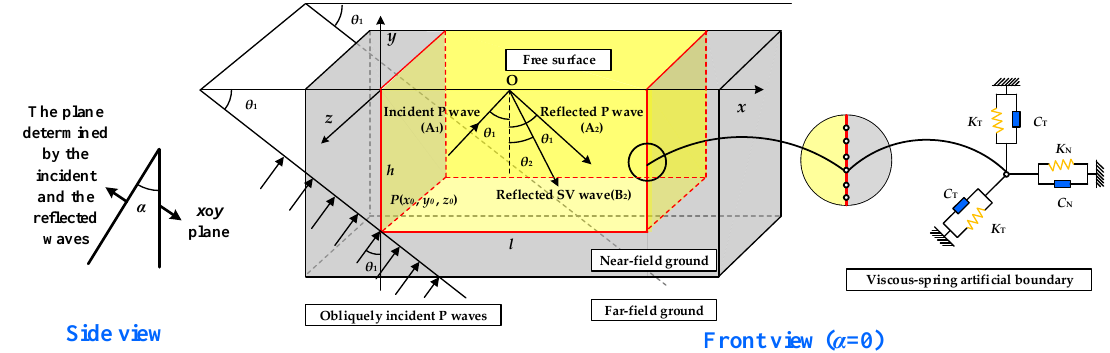
Figure3. Figure 3. The input of obliquely incident P waves and the model of the viscous-spring artificial boundary.